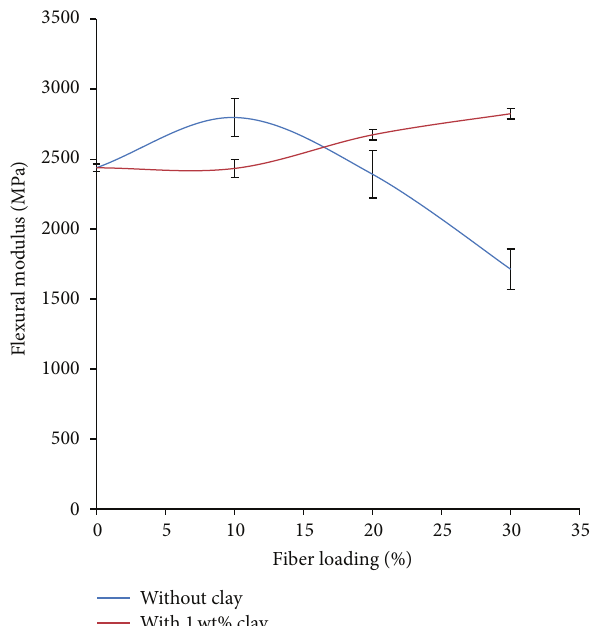
Figure 4: Impact strength of PLA/PCL/OPMF biocomposites and PLA/PCL/1wt% clay/OPMF hybrid